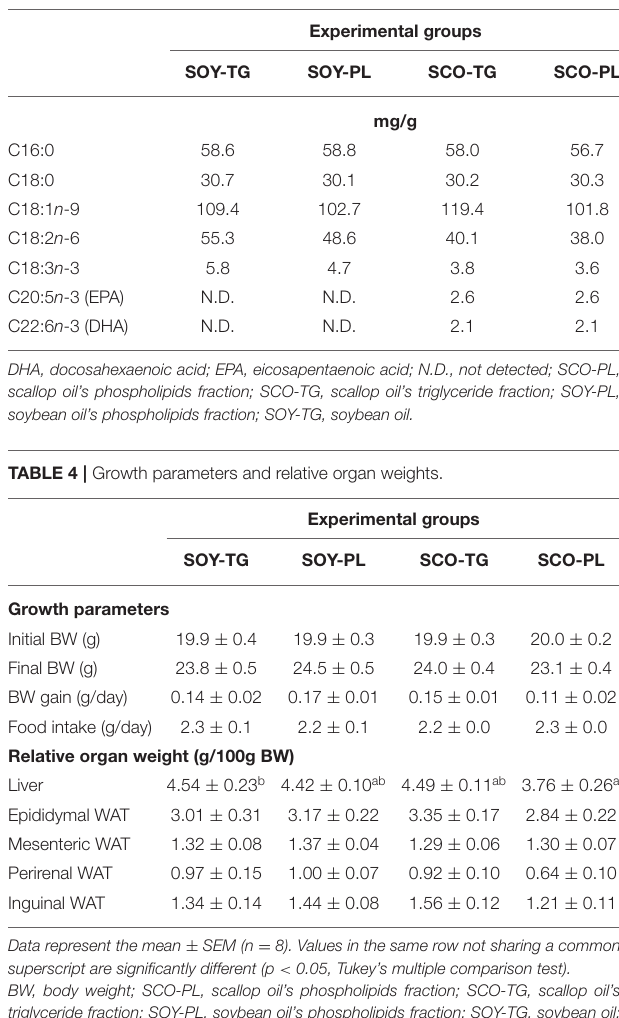
TABLE 3 | Main fatty acid composition of the experimental diets.